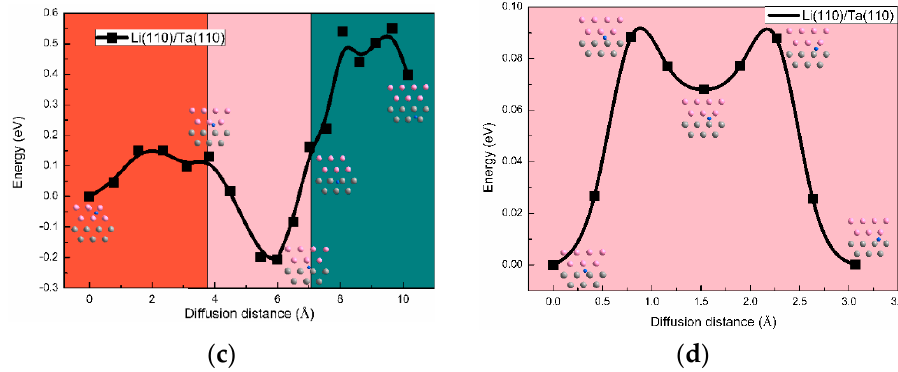
Figure 6. The diffusion barriers for the H atoms migrate through ( a ) and along ( b ) the Li (100)/Ta(100) interface. The diffusion barriers for the H atoms migrate through ( c ) and along ( d ) the Li (110)/Ta(110) interface.